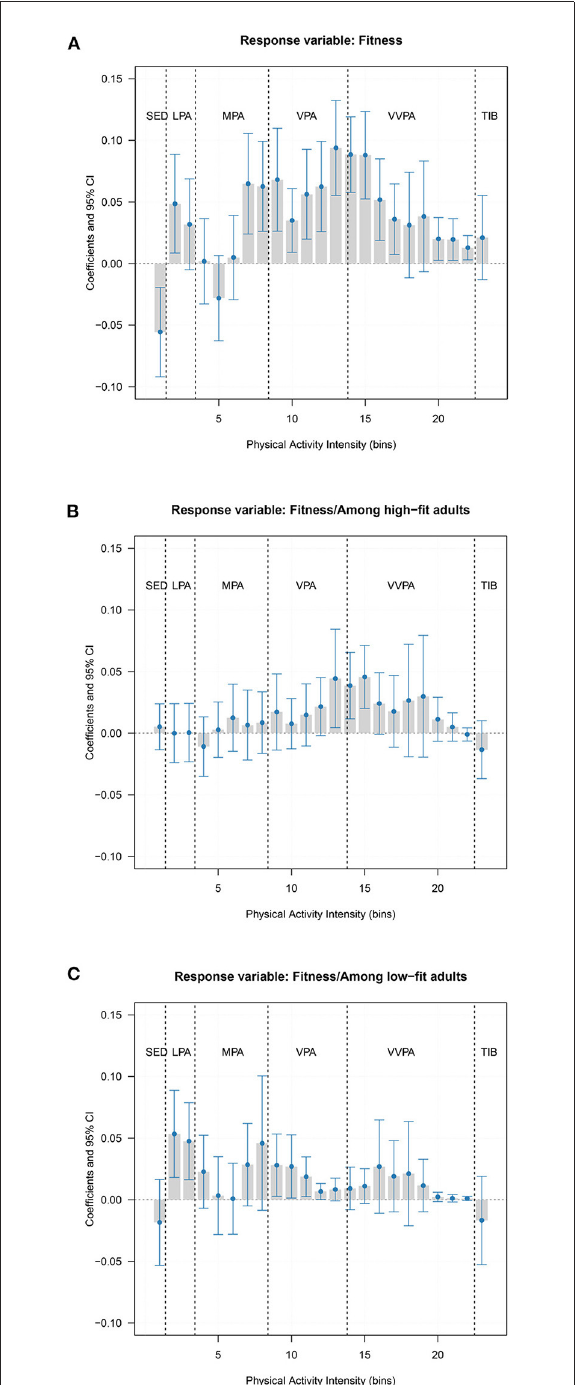
FIGURE2 Association between physical activity intensity and cardiorespiratory fitness. A positive bar indicates more time spent at that activity intensity is associated with a higher level of cardiorespiratory fitness, while a negative bar indicates more time spent at that activity is associated with a lower level of fitness. SED, Sedentary; LPA, Light physical activity; MPA, Moderate physical activity; VPA, Vigorous physical activity; VVPA, Very vigorous physical activity; TIB, Time in bed/sleep time. (A) Displays the results in all analytical sample, (B) shows the results in the high-fit adults, and (C) presents the results in the low-fit